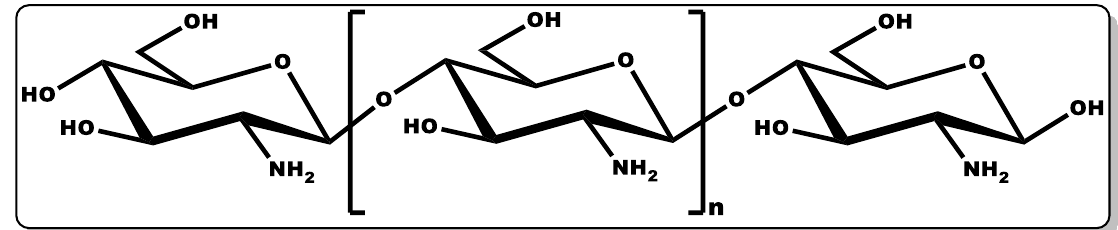
Figure 11. Structure of chitosan.